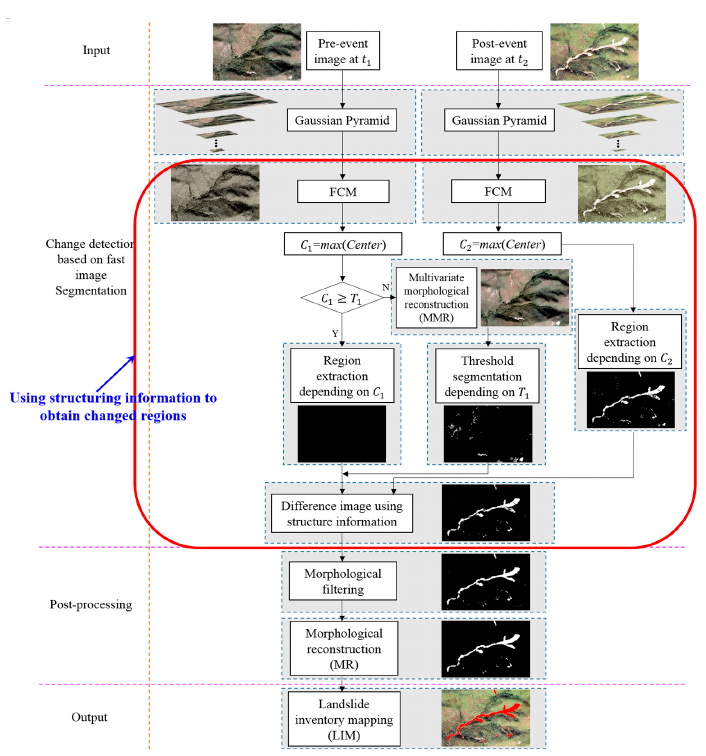
Figure 7. The framework of CDFFCM for landslide mapping (LM).